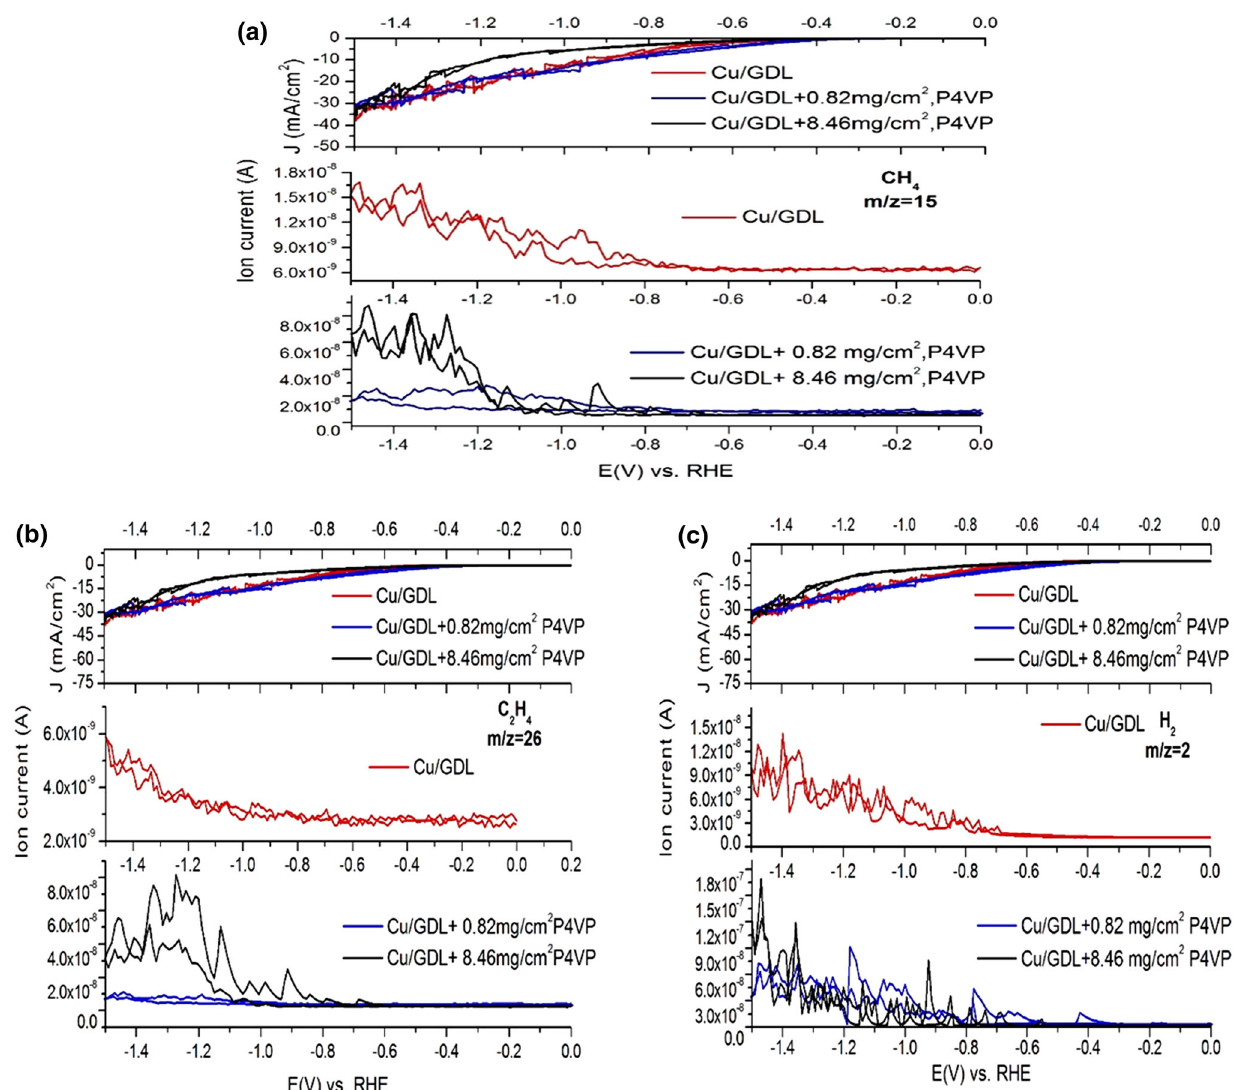
Fig. 5 Ion currents coupled with CV on unmodified and P4VP modified Cu/GDL as a function of applied potential in CO 2 -saturated phosphate buffer electrolyte at pH 6.7 (scan rate 1